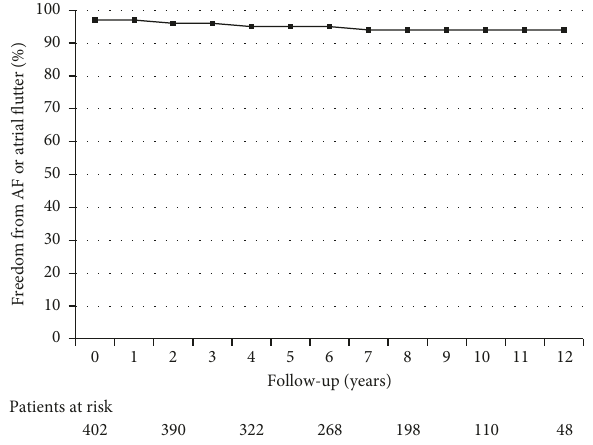
Figure 6: Kaplan–Meier plot showing freedom from AF over a 10- year time frame in patients aged ≥ 55 years versus < 55 years at the time of the procedure. p � 0 . 001 by log-rank